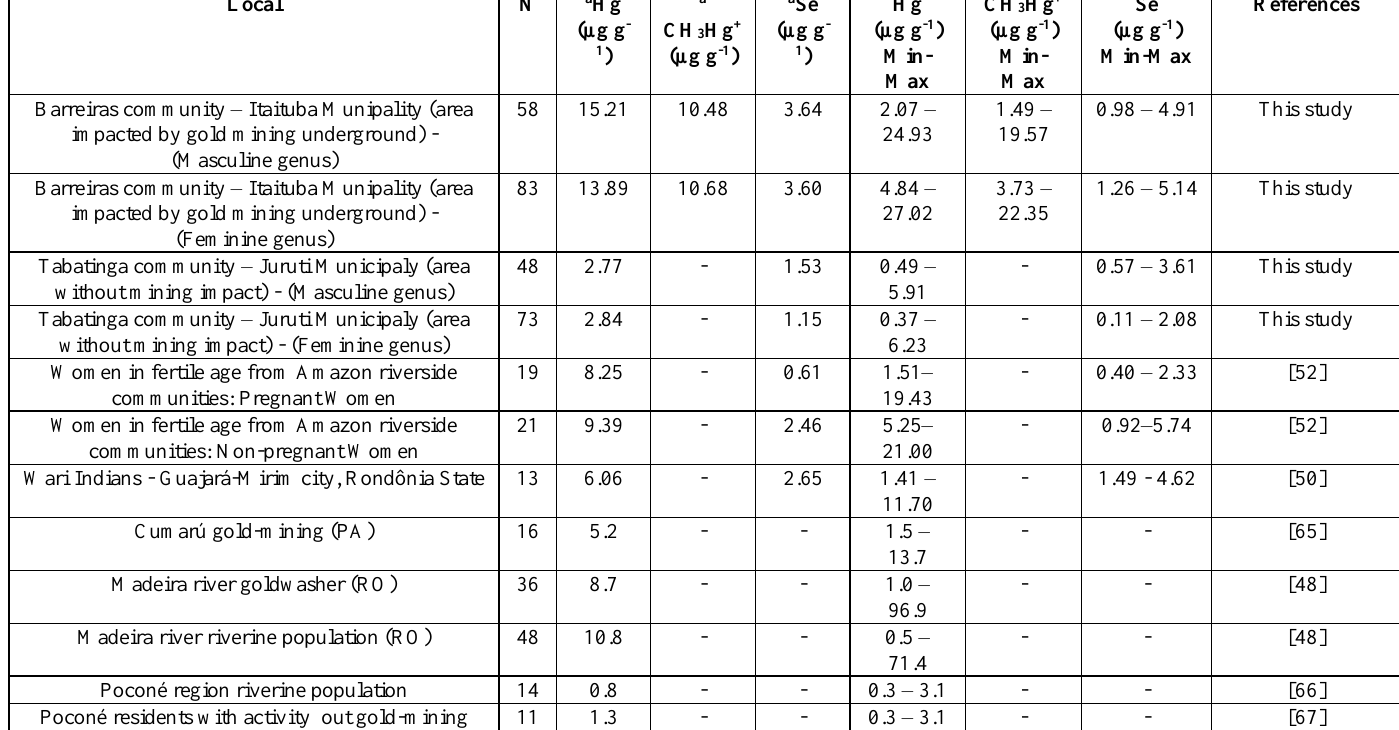
Table 5: Comparison between Hg, CH 3 Hg + and Se concentrations in hair samples ( μ g g -1 ), of people residents on gold-mining areas in